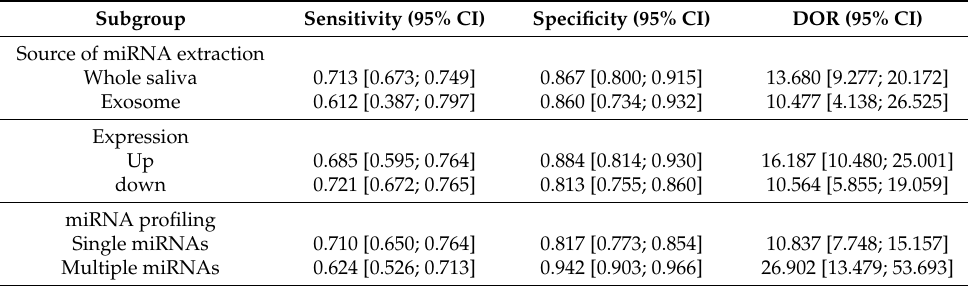
Figure 4. Summary receiver operator characteristic (SROC). A, miR-27b; B, miR-412-3p; C, miR-146a- 5p; D, miR-3928; E, miR-184; F, miR-512-3p; G, miR-31; H, miR-139-5p; I, miR-let-7a-5p; J, miRNA-9, -134, -210, and -455 and -196b; K, miR-24-3p; L, miRNA-9, -127, -134, -191, -222 and -455; M, miR-21; N, miR-145; O, miR-486-5p; P, miR-10b-5p; CI, Confidential interval; AUC, area under the ROC curve; DOR, Diagnostic odds ratio. Table 2. Subgroup